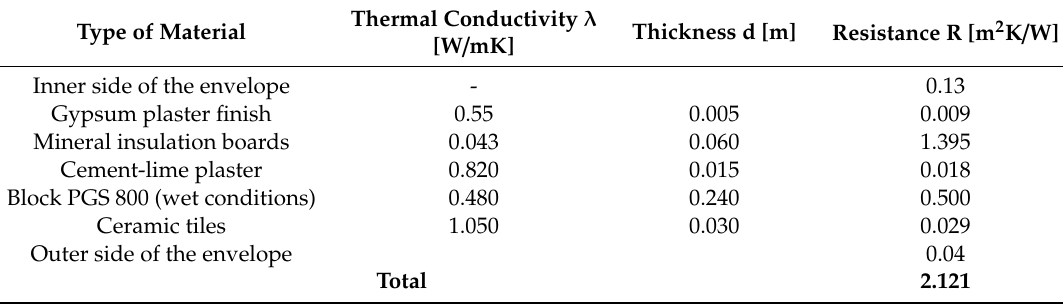
Table 3. Summary of thermal resistance for the gable wall (with mosaic)—after